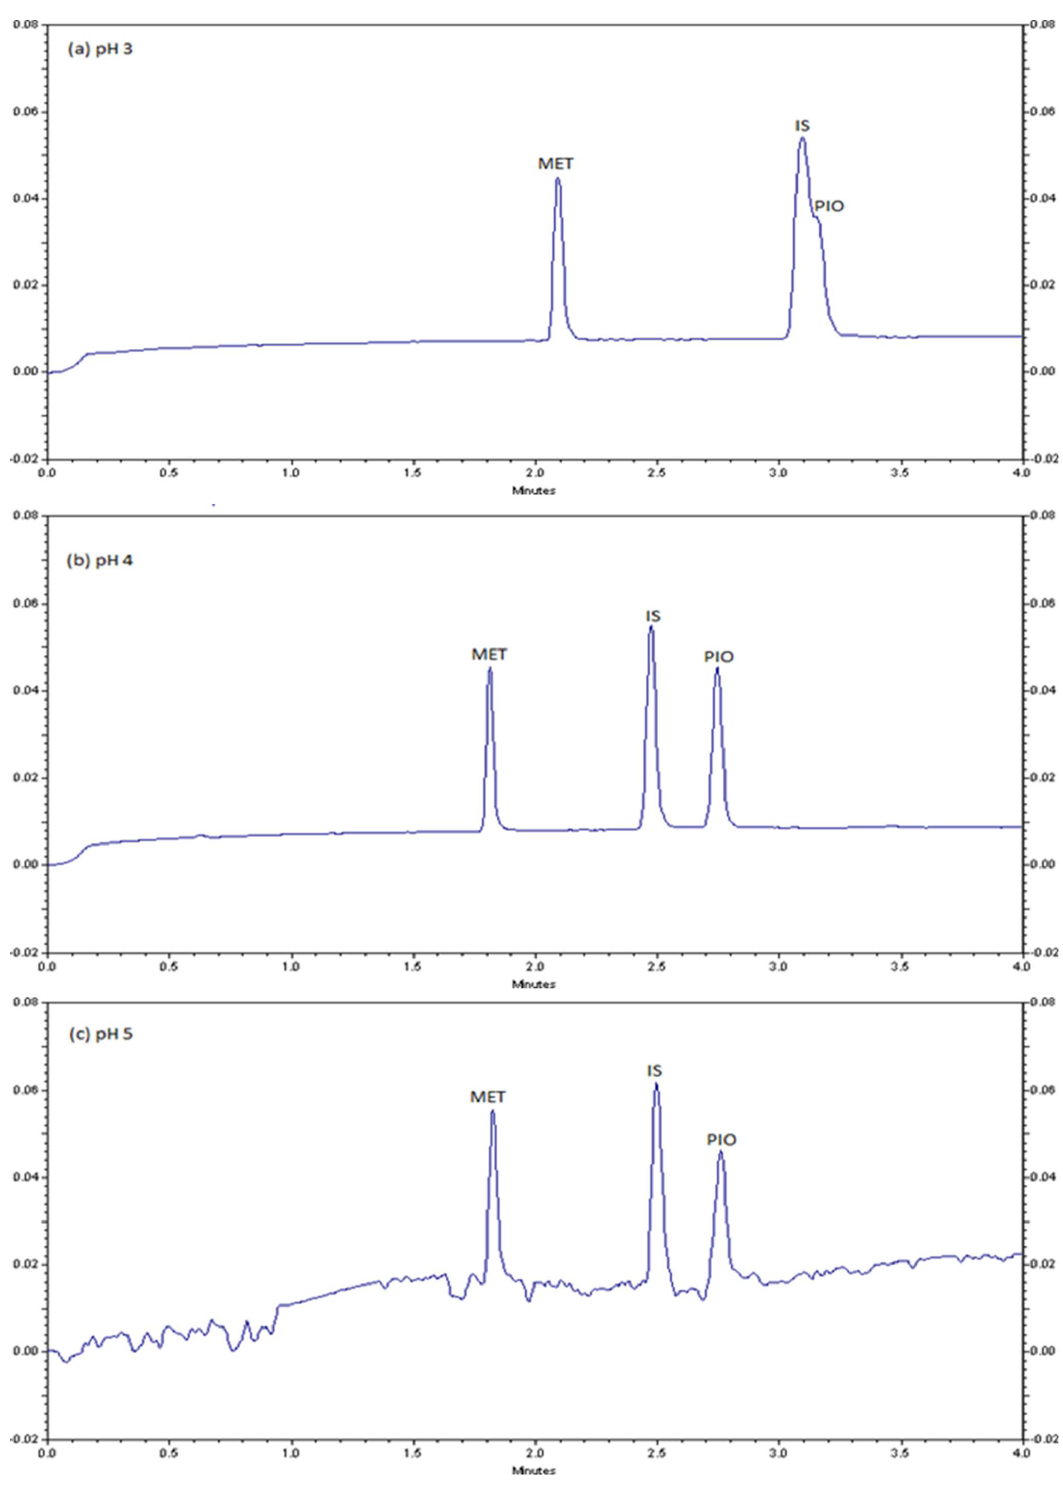
Figure 2. Typical electropherograms using different pH levels (( a ) pH 3, ( b ) pH 4, and ( c ) pH 5 for the separation of 75 µ g/mL metformin (MET), 75 µ g/mL internal standard (IS), and 50 µ g/mL pioglitazone (PIO). Separation conditions: capillary column dimension 37 cm × 52 µ m, 75 mmol/L sodium phosphate buffer, 10 s hydrodynamic injection time at 0.5 psi pressure, 25 kV separation voltage, 25 ◦ C column temperature, UV detection at 210